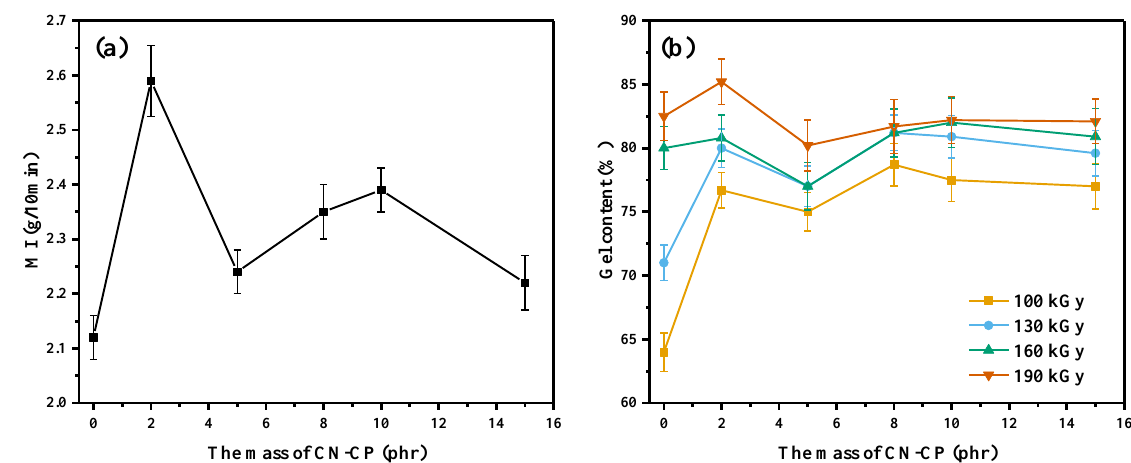
Figure 2. Melt index ( a ) and relationship between radiation dose and gel content ( b ) of the composites. Diagrams of composite preparation and EB-irradiation processes are presented in Figure 3. The above analyses confirmed that upon EB-irradiation, highly crosslinked PE/EVA networks, in which organic CN-CP and inorganic Mg(OH) 2 /Al(OH) 3 particles were distributed, were fabricated. This composition can be expected to have the desired combination of high strength, good heat resistance, sufficient flexibility, and excellent flame retardancy.